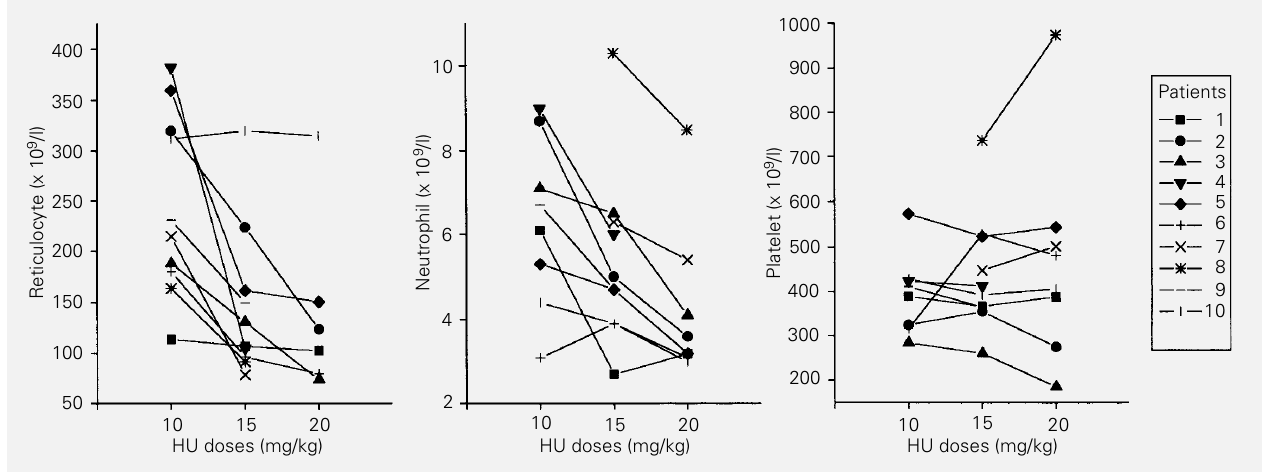
Figure 2 - Effect of different doses of hydroxyurea (HU) on mean reticulocyte, neutrophil, and platelet counts for 8 patients with sickle cell anemia (patients 1-8) and 2 patients with S(cid:223) thalassemia (patients 9 and